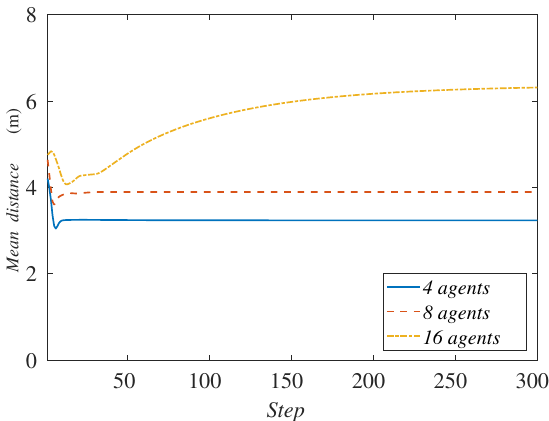
Figure 11. Mean agent distance to the formation center along the simulation depending on the number of agents.